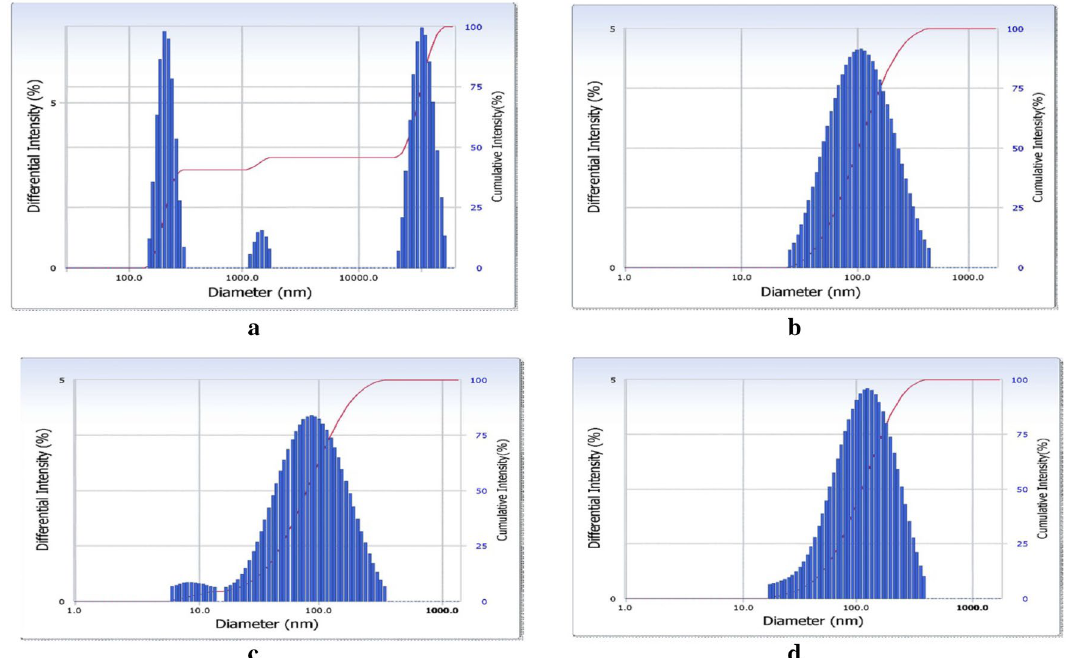
Figure 2. Dynamic light scattering showing intensity distribution graph representing the average hydrodynamic size of ( a ) curcumin; ( b ) nanocurcumin particles; ( c ) empty-virosome; ( d )